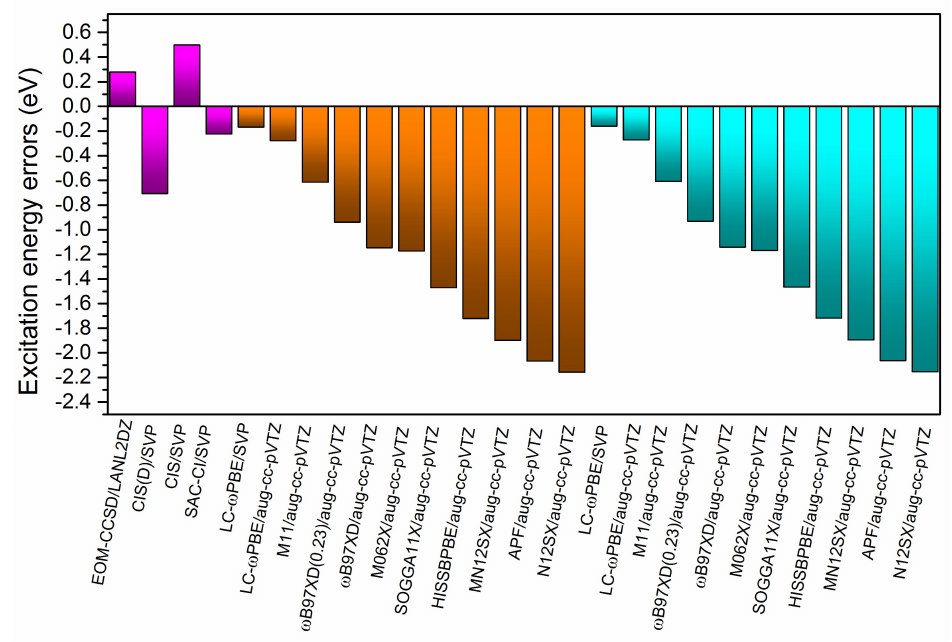
Figure 2. The calculated excitation energy errors relative to the EOM-CCSD/SVP benchmark result for the lowest singlet charge transfer excited state. The purple, brown and blue regions represent the results of ab initio, full time-dependent DFT (TDDFT) and Tamm–Dancoff approximation (TDA)-TDDFT methods, respectively.